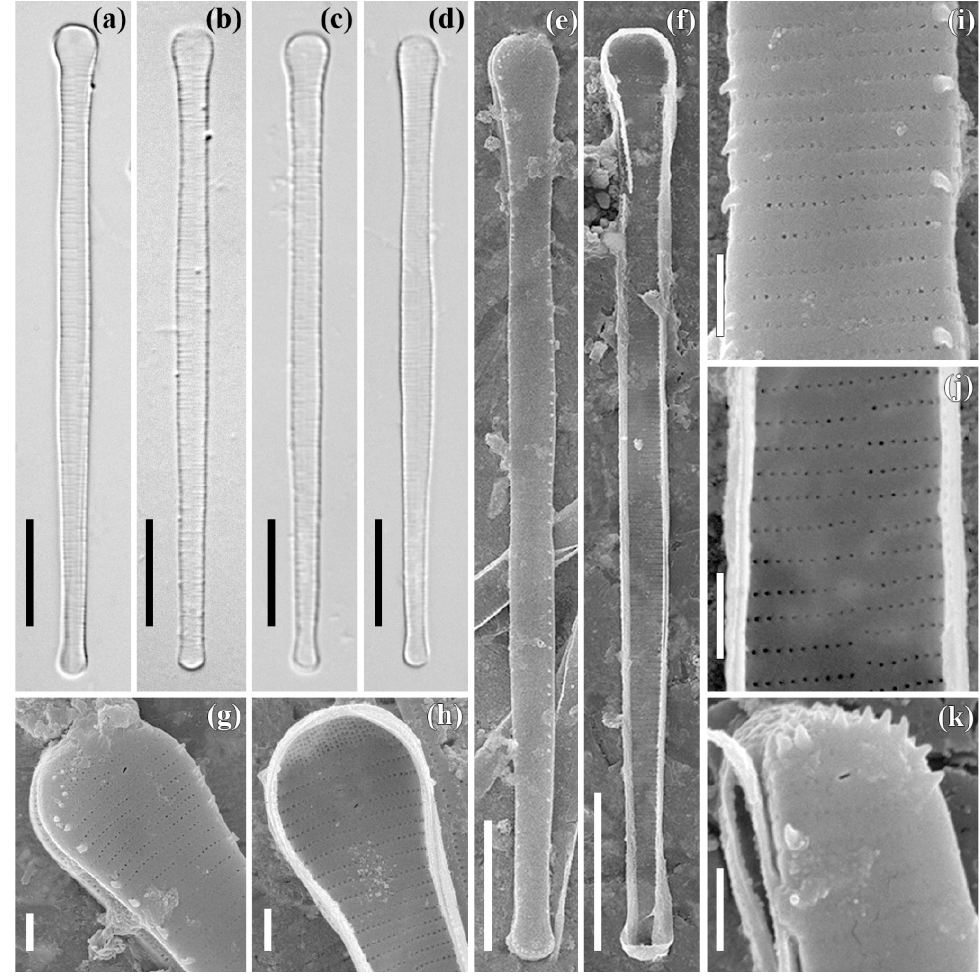
Figure 1. Asterionella formosa Hassal. Strain ARC01. Slide no. 08438. LM, DIC ( a – d ). SEM, external view ( e , g , i , k ), internal view ( f , h , j ). ( a – d ) size diminution series; ( e , f ) general view; ( g , h ) headpole; ( i , j ) central part; ( k ) footpole. Scale bars: 10 μ m ( a – f ), 1 μ m ( g – k ).